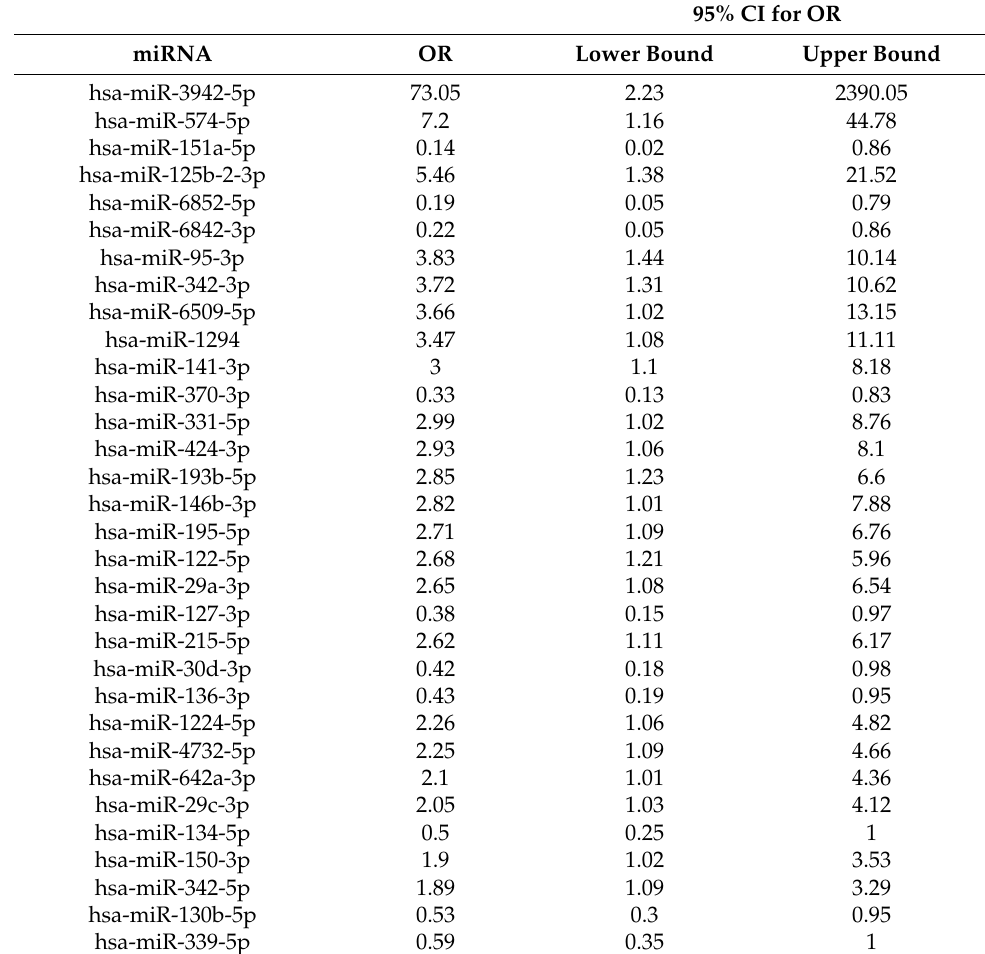
Table 3. Significant miRNAs in the High Vitamin D Treatment Group in